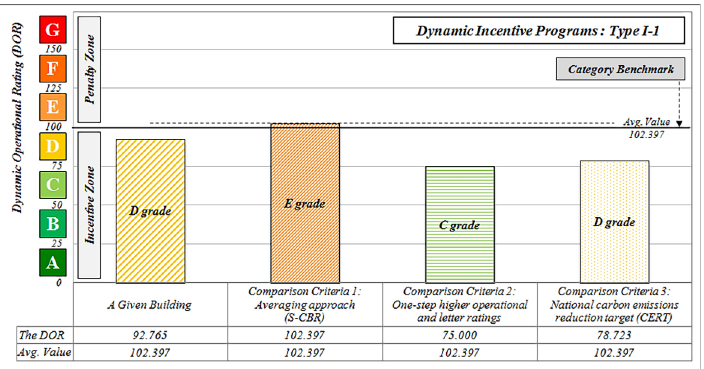
Fig. 1. Comparison chart for the incentive programs (the operational